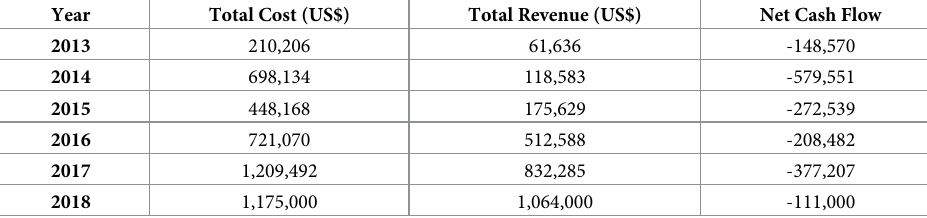
Table 2. Year wise details of total cost, total revenue and net cash flow attained by the Haiti salt enterprise between 2013 to 2018. The total costs shown are calculated using the cost data for the production of all three types of salt, while total revenue is calculated using the revenue data from the sale of all three types of salt for each year.